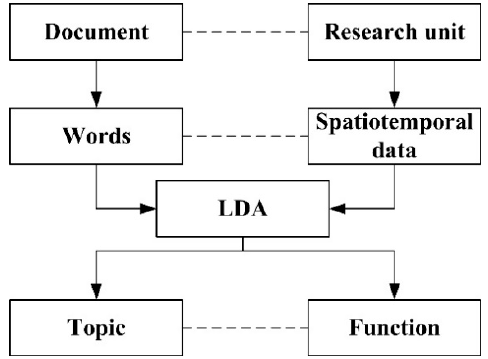
Figure 2. Relationship between document-topic and area-function.